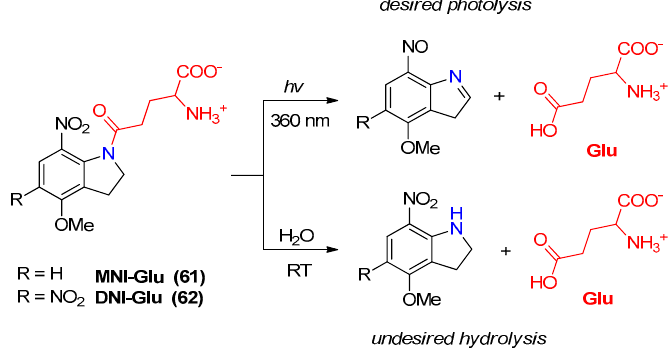
Figure 23. Chemical structures of MNI–Glu (R = H) and DNI-Glu (R = NO 2 ) and their photochemical reactivity ( top ) and hydrolytic reactivity ( bottom ).